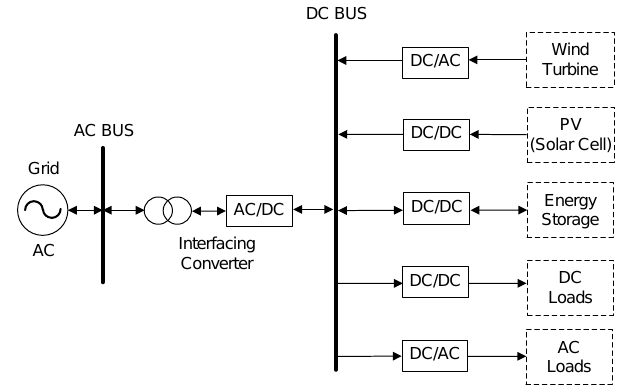
Figure 2. Typical configuration of a DC microgrid.